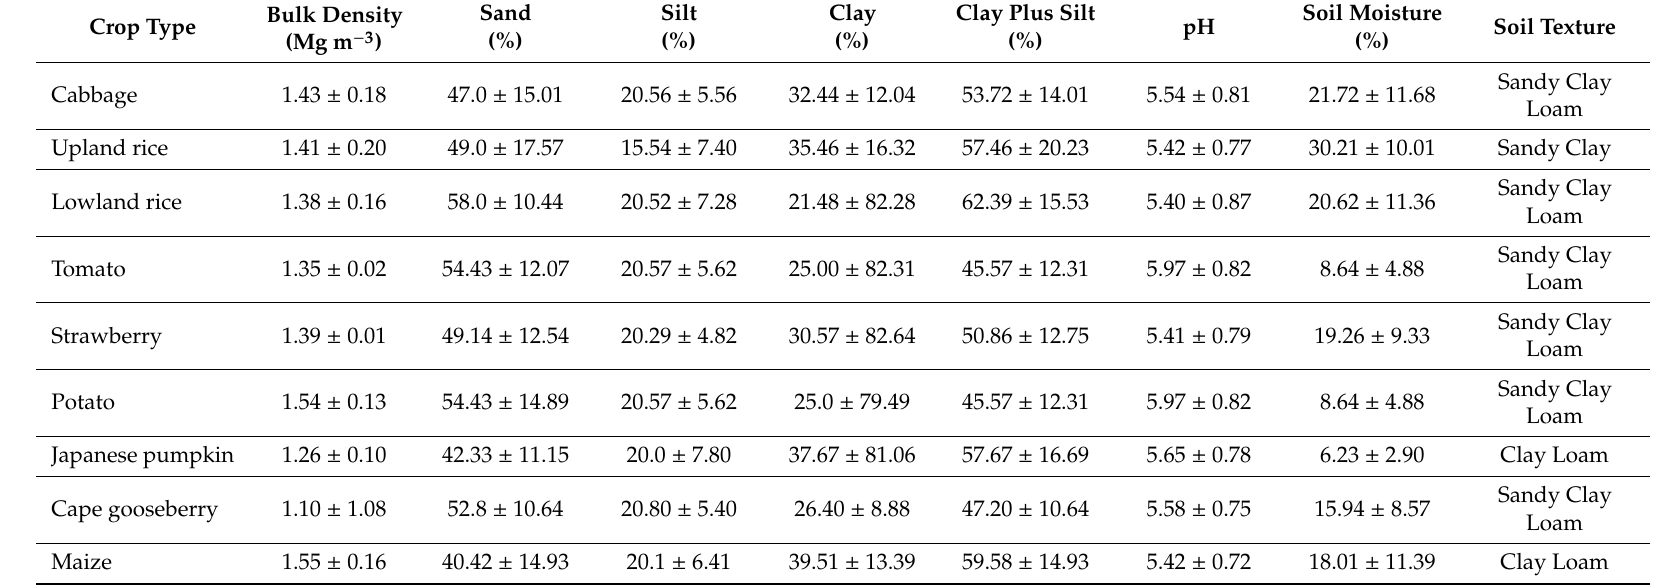
Table 1. Soil physical and chemical properties of nine crop types at topsoil (0–30 cm) (mean ±